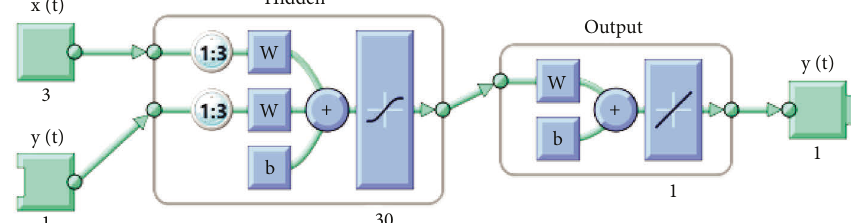
Figure 3: Neural network: one-hidden layer and 30 neurons.